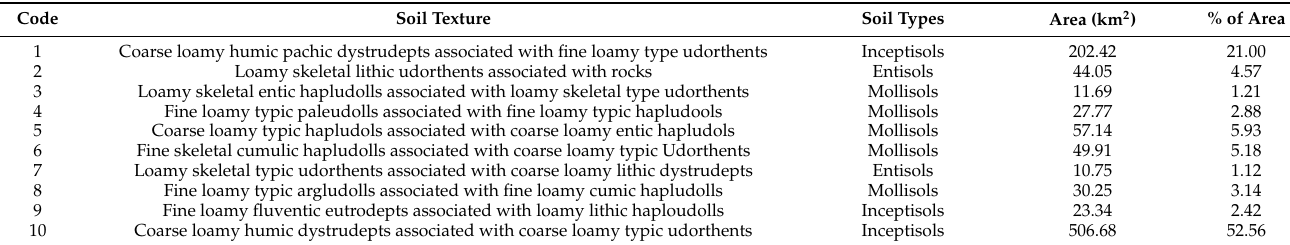
Table 2. Characteristics of soil types and soil textural classes of East